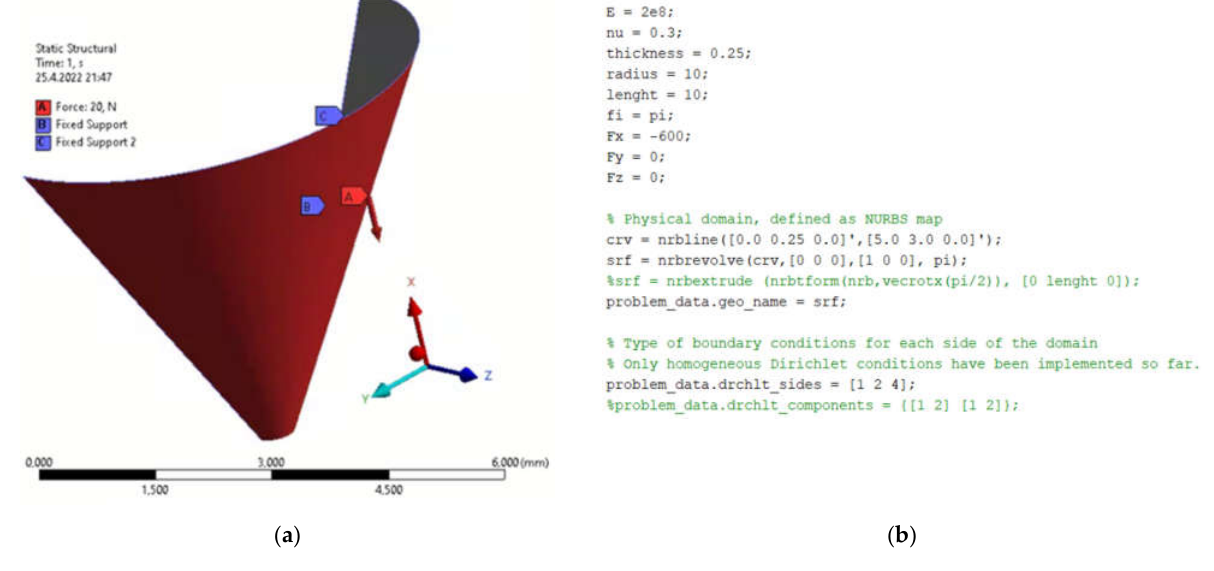
Figure 5. Geometric characteristics, boundary conditions and material properties ( a ) FEM program;